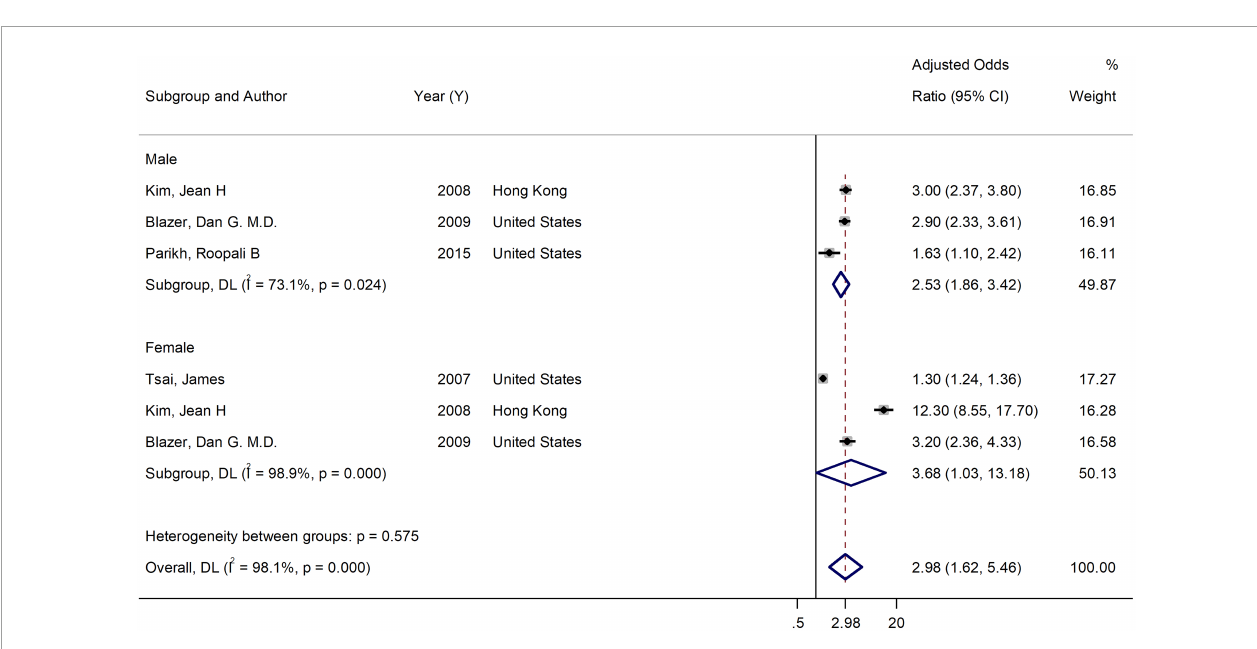
FIGURE3 Forest plot of the association between binge-drinking and current smoking by gender. Weights and between-subgroup heterogeneity test are from random-effects